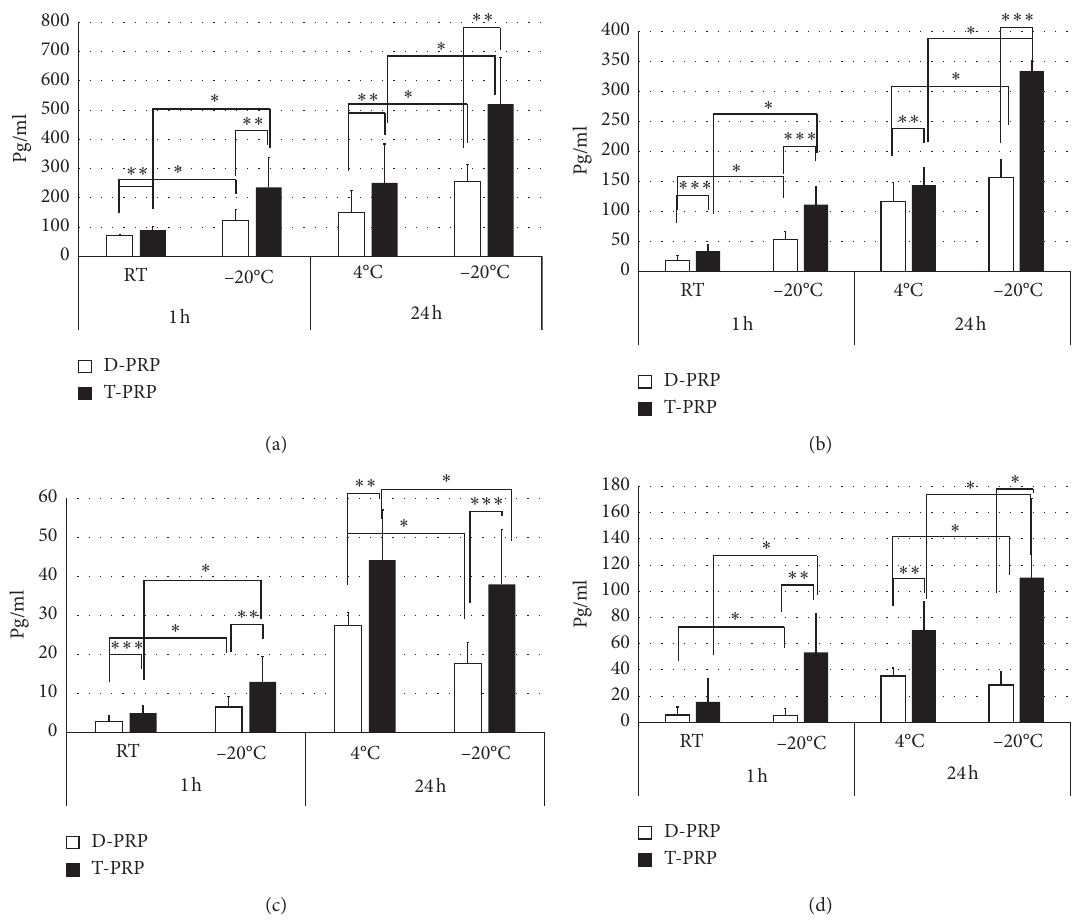
Figure 2: Growth factors in PRP: (a) PDGF-BB, (b) PDGF-AB, (c) EGF, and (d) VEGF. RT, room temperature; ∗ P < 0.05; ∗∗ P < 0.01; ∗∗∗ P < 0.001 ( n �